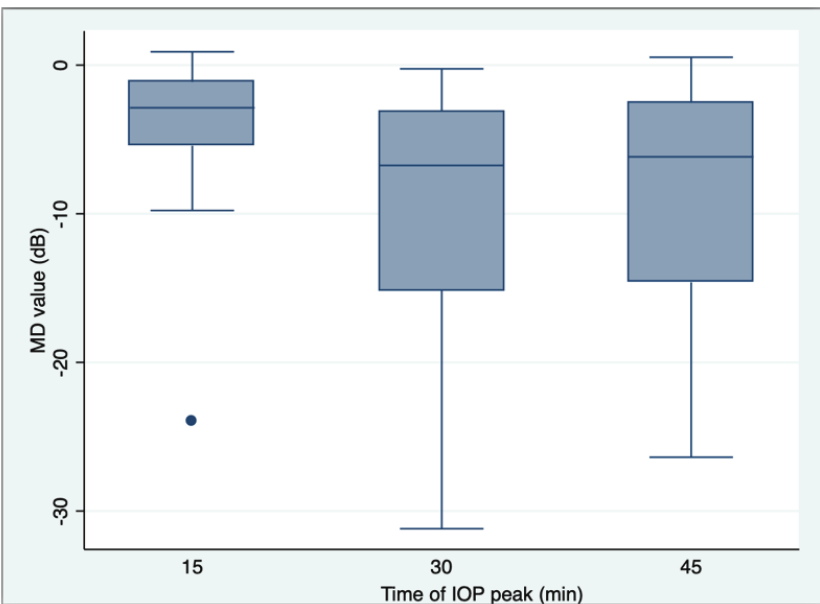
Figure 1. Distribution of mean deviation value at each time point of the WDT. † Boxplot depicting the MD distribution. MD, mean deviation; IOP, intraocular pressure; WDT, water-drinking test; min,